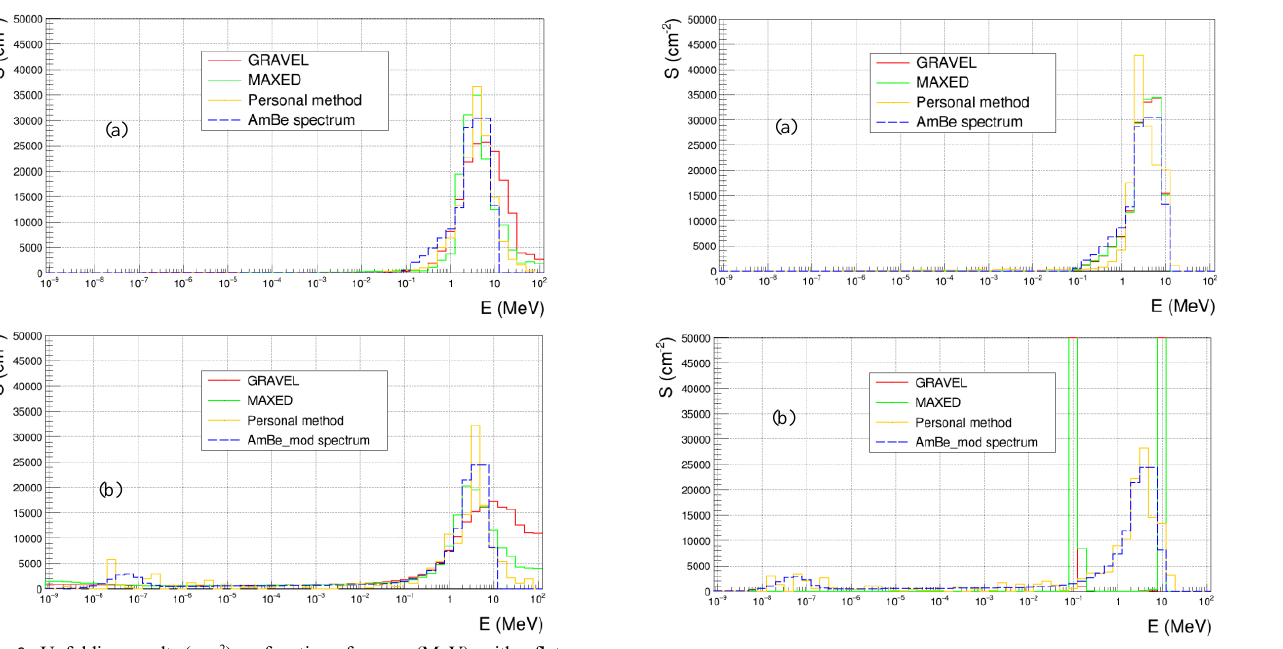
Fig. 7. Unfolding results (cm -2 ), as function of energy (MeV), with an unmoderated Am/Be guess spectrum and high statistics (Φ = 1.41×10 5 cm -2 ). (a), unmoderated Am/Be source. (b), moderated Am/Be source.